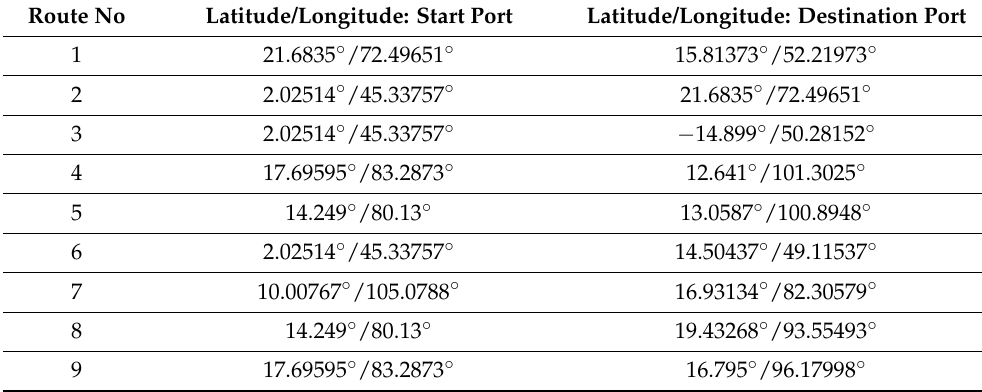
Table 3. Maritime Route